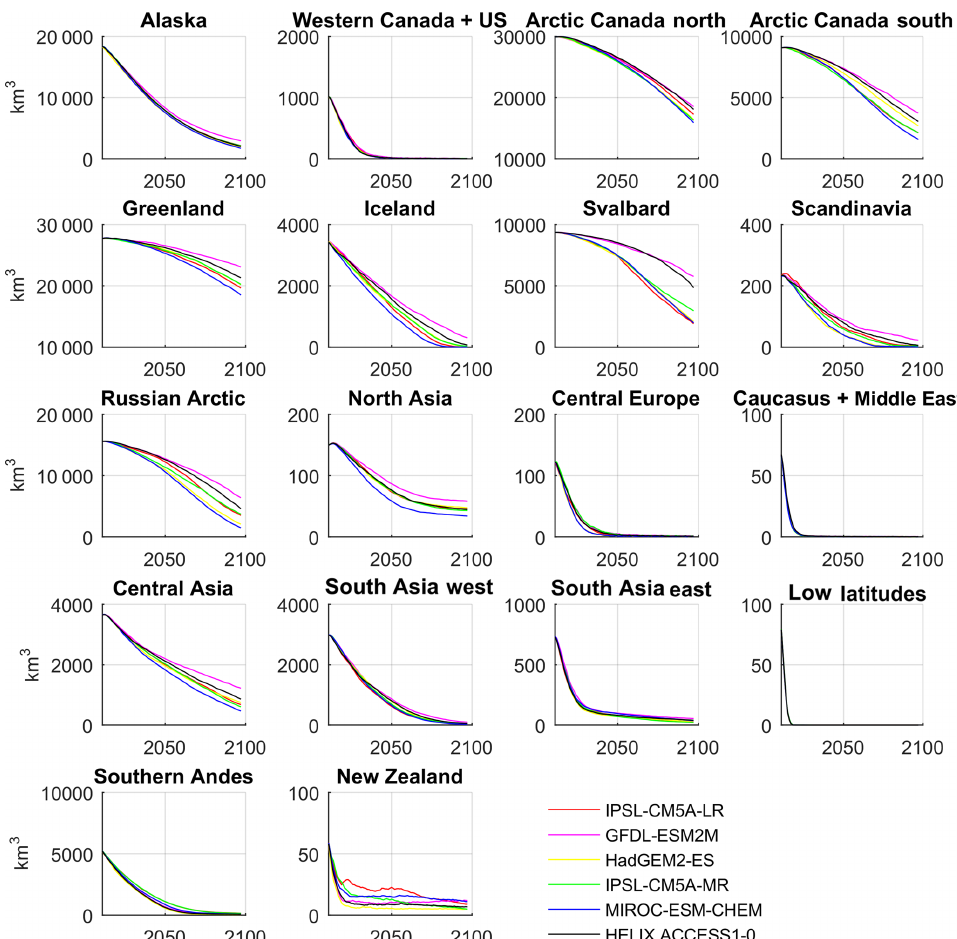
Figure 8. Regional glacier volume projections using the HadGEM3-A ensemble of high-end climate change scenarios.